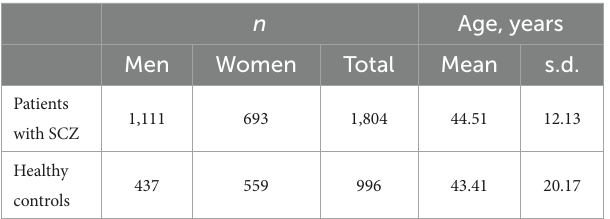
TABLE 1 Characteristics of the study sample